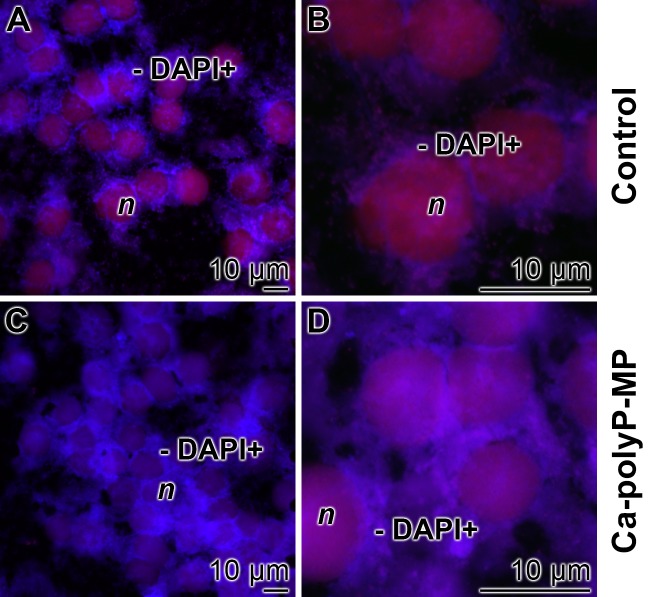
Subcellular localization of DRAQ5-positively stained areas in red fluorescence (nuclei; n) as well as DAPI blue fluorescing cytoplasmic regions (DAPI+) in HUVEC cells; cLSM.(A, B) Controls, not exposed to polyP microparticles; only narrow DAPI+ areas around the nuclei are visible. (C, D) Cells incubated with 30 μg/mL of “Ca-polyP-MP” for a period of 24 h show a bulky, more homogeneous staining with DAPI of the extra-nuclear environment.